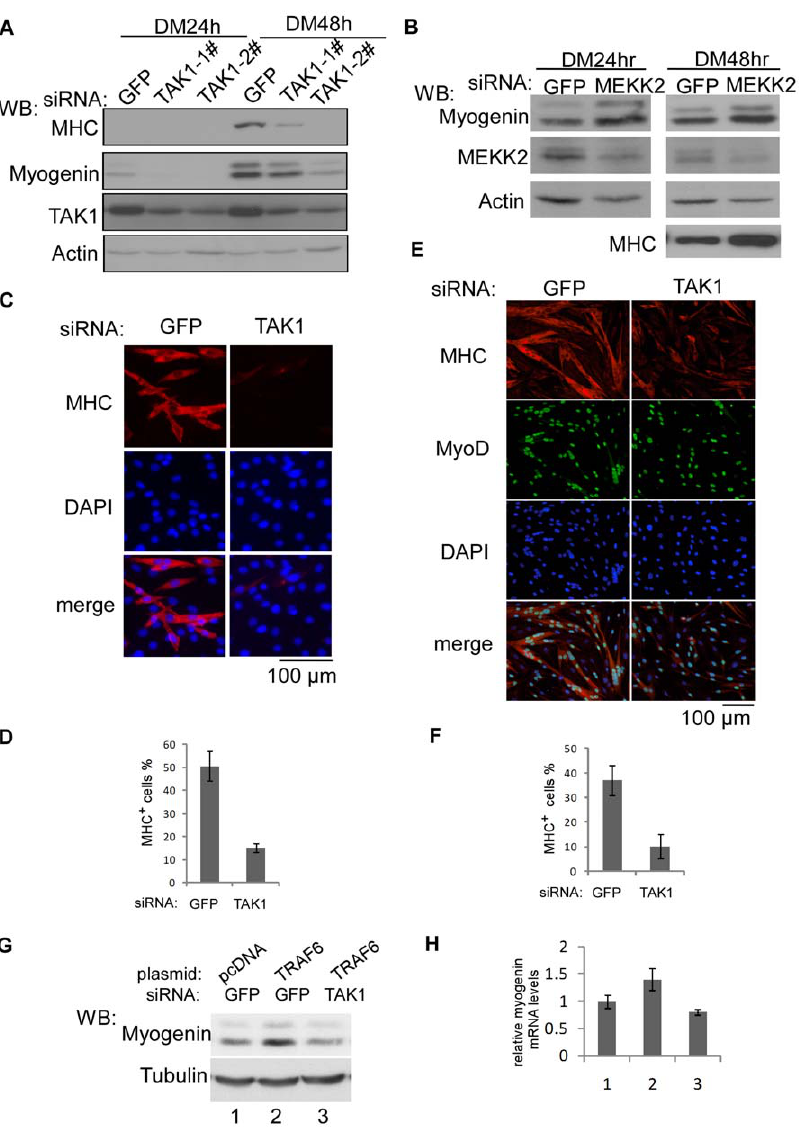
Figure 3. TAK1 was required for myogenic differentiation. (A, B) C2C12 cells were transfected with various siRNAs as indicated. Cells were harvested at the indicated time points and WCEs were subjected to SDS-PAGE and Western blot analysis. (C–F) C2C12 cells (C, D) or primary myoblasts (E, F) were transfected with either the GFP-siRNA or the TAK1-siRNA. Forty-eight hours after induction of differentiation, cells were fixed and subjected to immunostaining for MHC or MyoD. The nuclei were counterstained with DAPI. In (D, F), the percentage of MHC-positive cells was calculated the same way as that described in the legend of Fig. 1(E, G). (G, H) C2C12 cells were co-transfected with an empty vector or a TRAF6- expressing vector together with the GFP-siRNA or TAK1-siRNA as indicated. Twenty-four hours after induction of differentiation, cells were harvested for subsequent analysis: WCE were subjected to SDS-PAGE and Western blot analysis (G), while total RNA was prepared for RT-qPCR analysis (H) of relative myogenin gene expression. 1, 2, 3 in (G) and (H) denote the same set of samples.